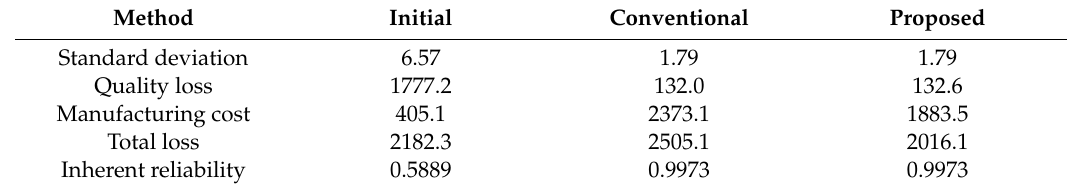
Table 5. Comparison of results before and after robust optimization.